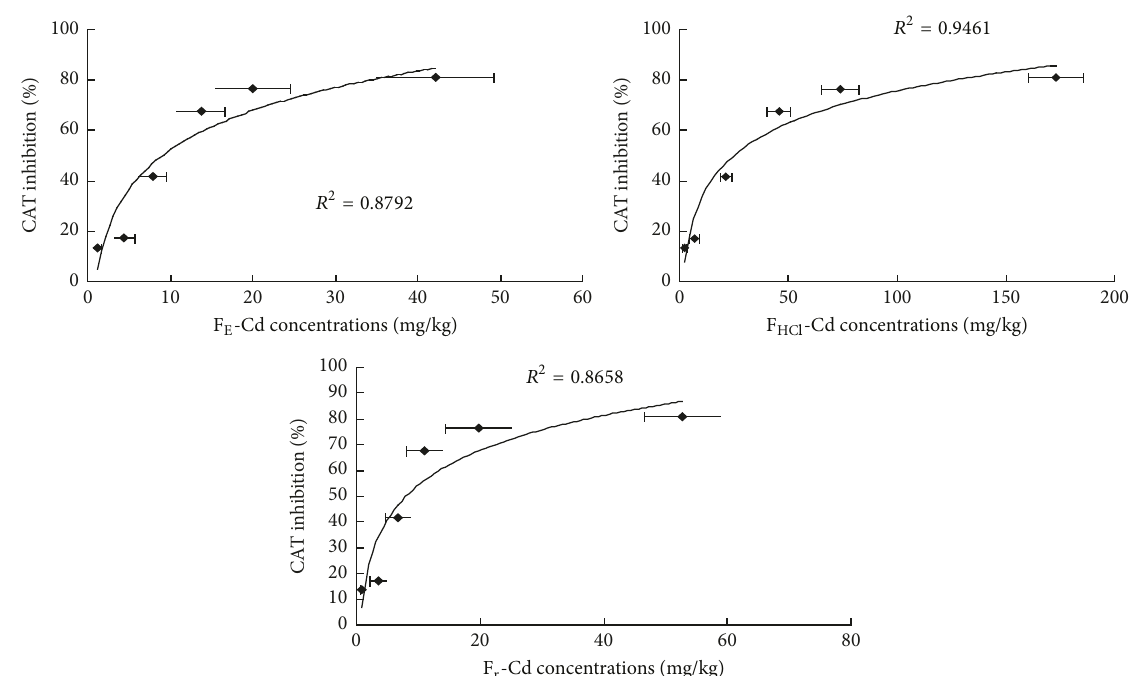
Figure 6: Inhibition of CAT of duckweed root as a function of Cd associated with different chemical forms.